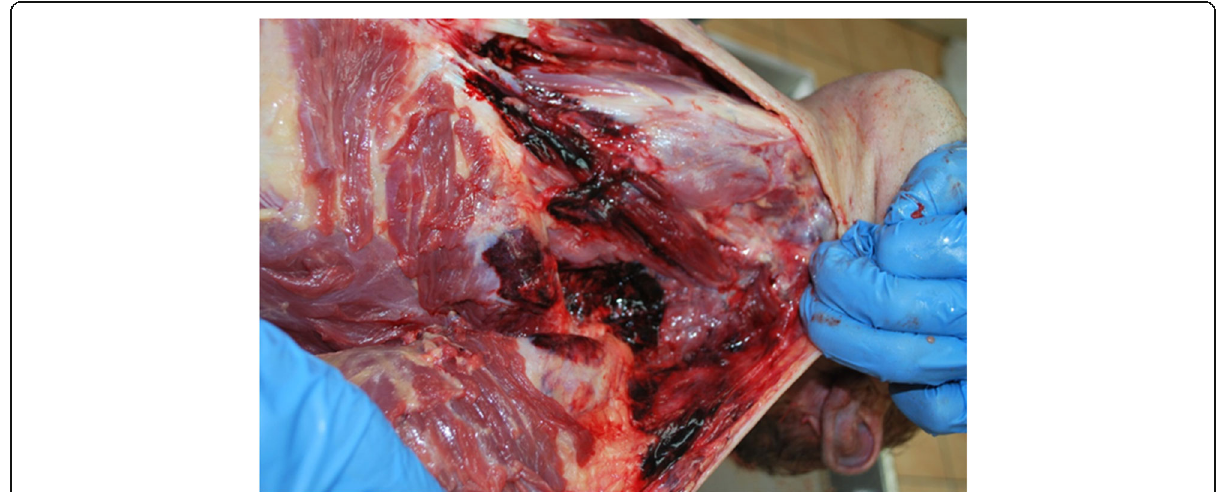
Fig. 2 Hematomas and shallow lacerations of subcutaneous and muscle tissue. Legend: The internal examination revealed no pathological findings except shallow injuries of subcutaneous tissue, with no injuries of jugular veins or carotid arteries